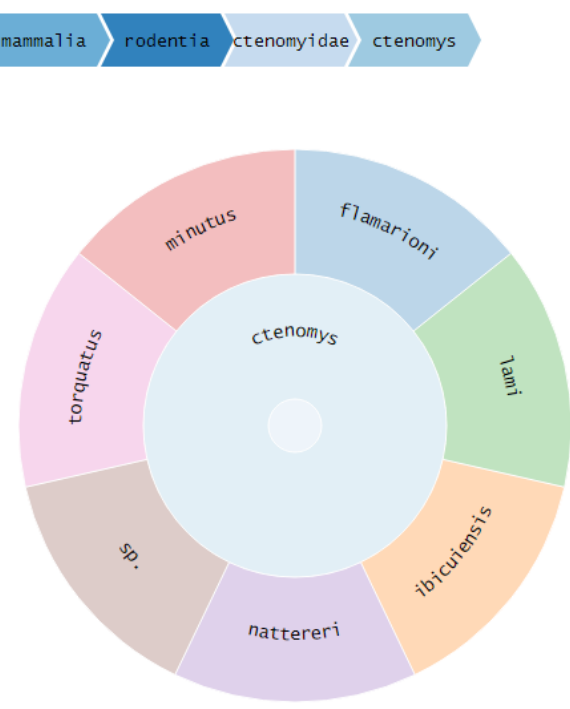
Figure 13. Breadcrumbs and the Sunburst visualization, showing all parent nodes of the zoomed-in